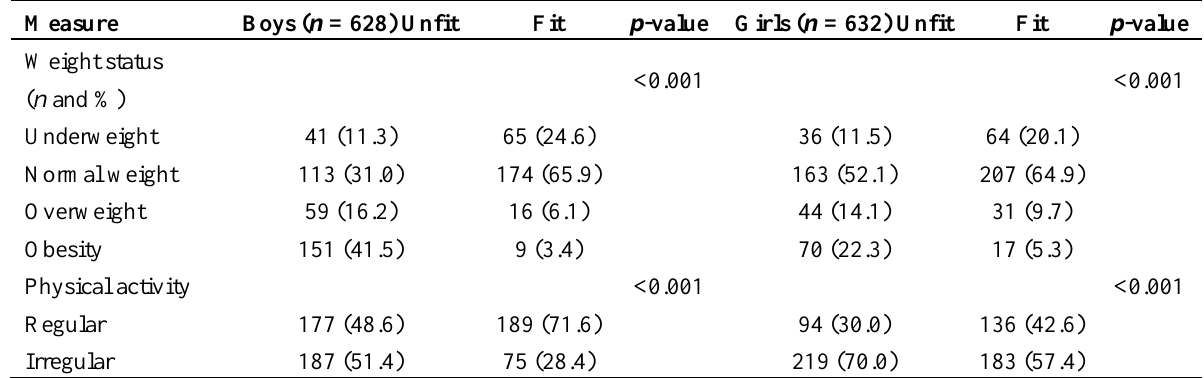
Table 2. Characteristics of the participants in the extreme qualities based on gender and cardiorespiratory fitness.